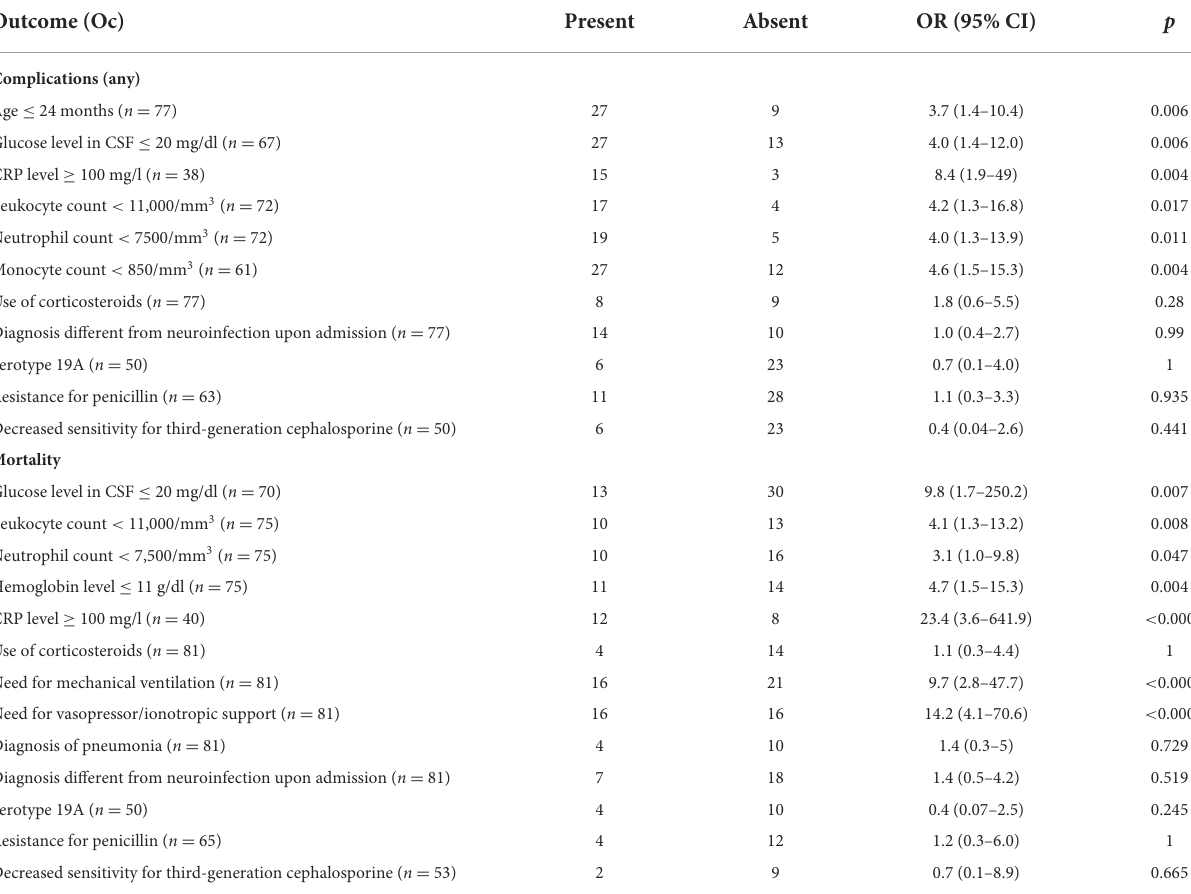
TABLE 2 Variables associated with greater complications and greater